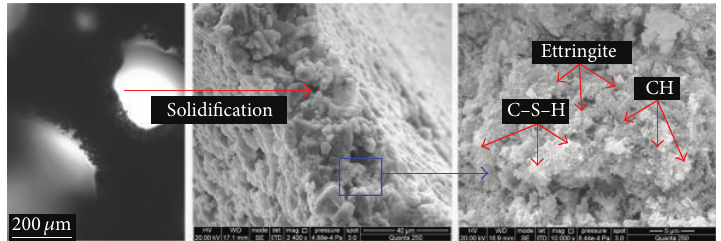
Figure 11: The SEM images of bubble